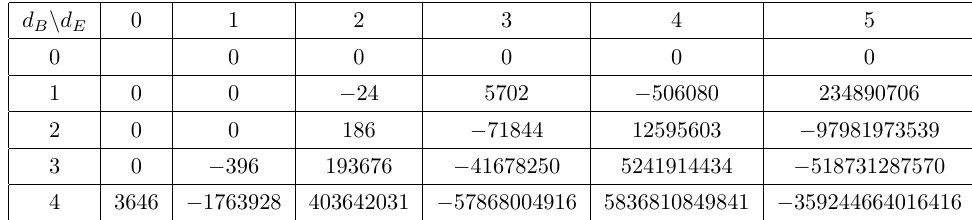
for the genus ( g ) = (2 , 1) L , g R ( d B ,d E )